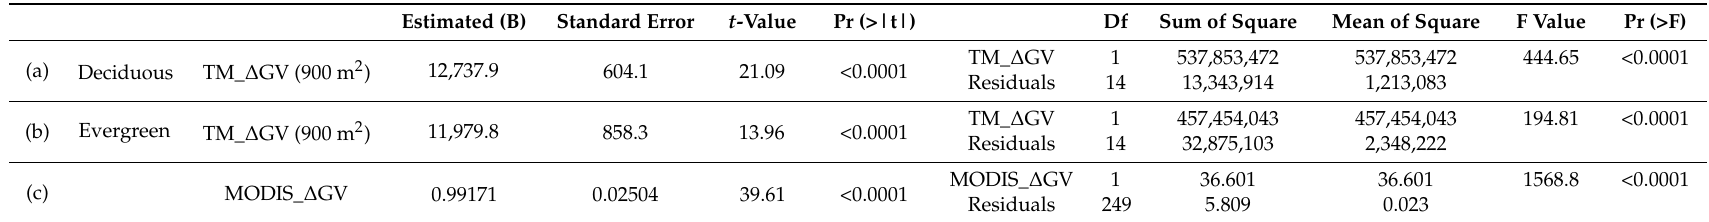
Table 1. Linear regression model and ANOVA analysis between GV from Landsat TM and field measured mortality: (a) For deciduous; (b) For evergreen; and (c) Between GV from Landsat TM and